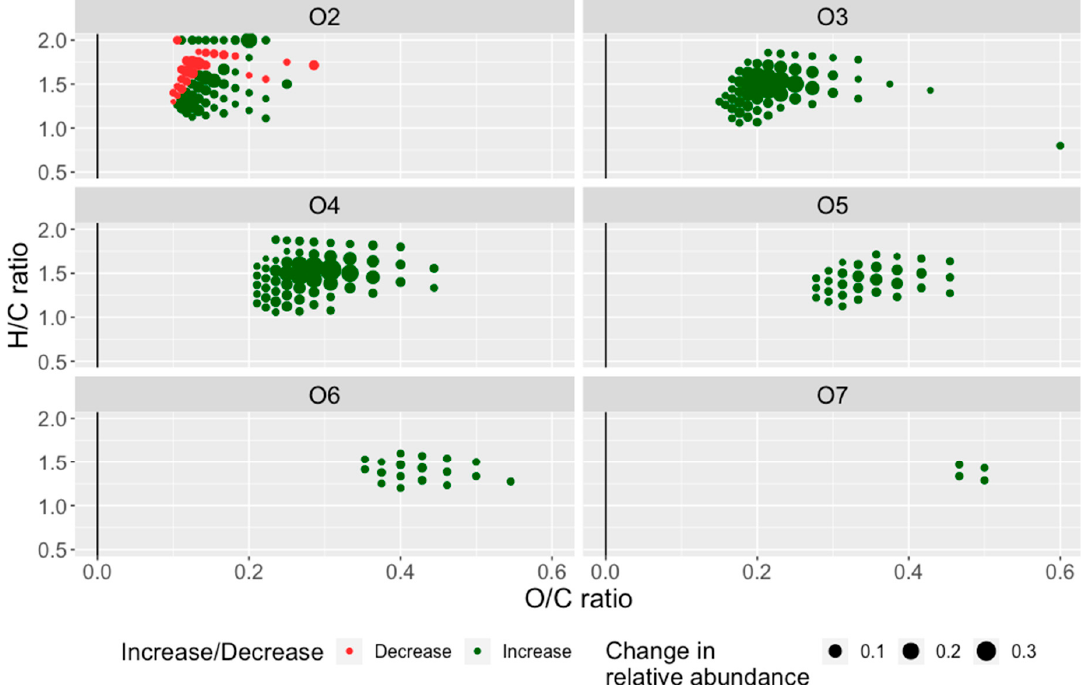
Figure 5. Van Krevelen diagram of the net-change in the relative abundance for O 2 , O 3 , O 4 , O 5 , O 6 , and O 7 NAFC formulae assigned across the sampling period and analyzed by negative-ion ESI-high- resolution Orbitrap-MS.